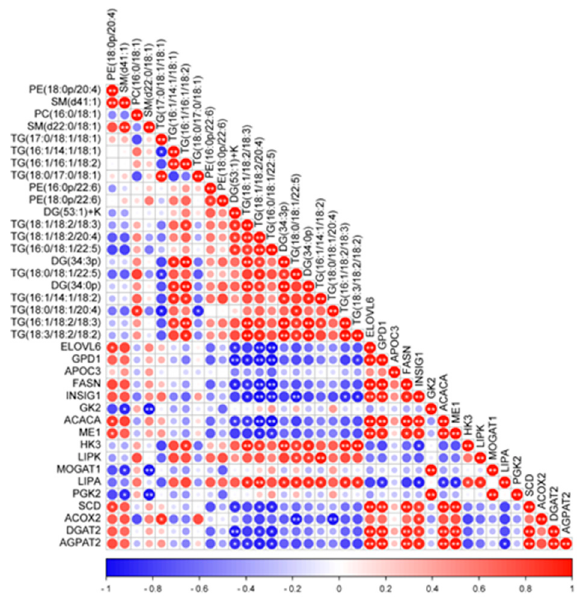
Figure 4. The correlation of crucial DLs and DEGs involved in regulating the fat deposition in yak subcutaneous fat. * represents p < 0.05 and ** represents p < 0.01. Circles with no * or ** represent p > 0.05. Red or blue represent positive or negative correlation, respectively. Deeper colors represent stronger correlations.